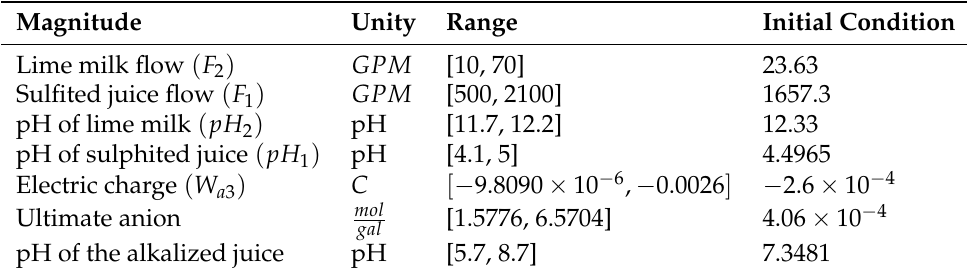
Table 4. Interval of engineering units for the normalization of the variables of the alkalinization process of the sugar cane juice.